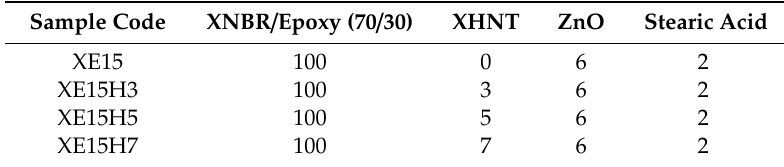
Table 1. Formulations of various carboxylated nitrile butadiene rubber (XNBR) / epoxy / XNBR